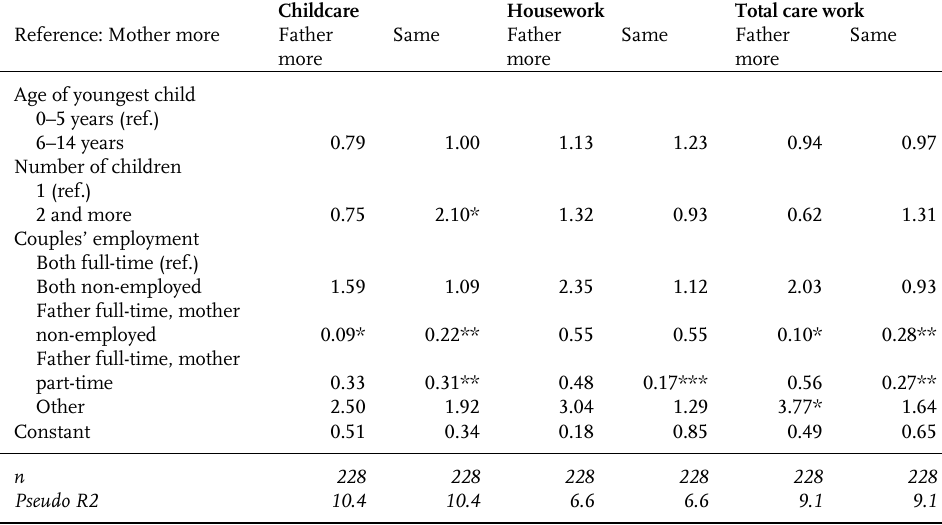
Table A9: Predictors of distribution of childcare, housework, and total care work in couples (3 categories), May 2020, multinomial logistic regression models Childcare